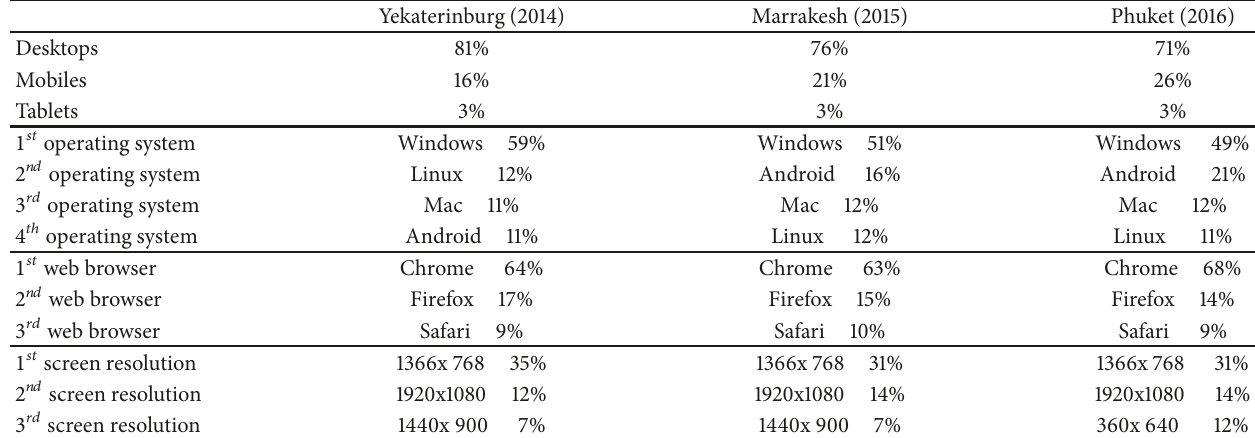
Table 3: World Finals 2014-16 total audience details (REMOTE).